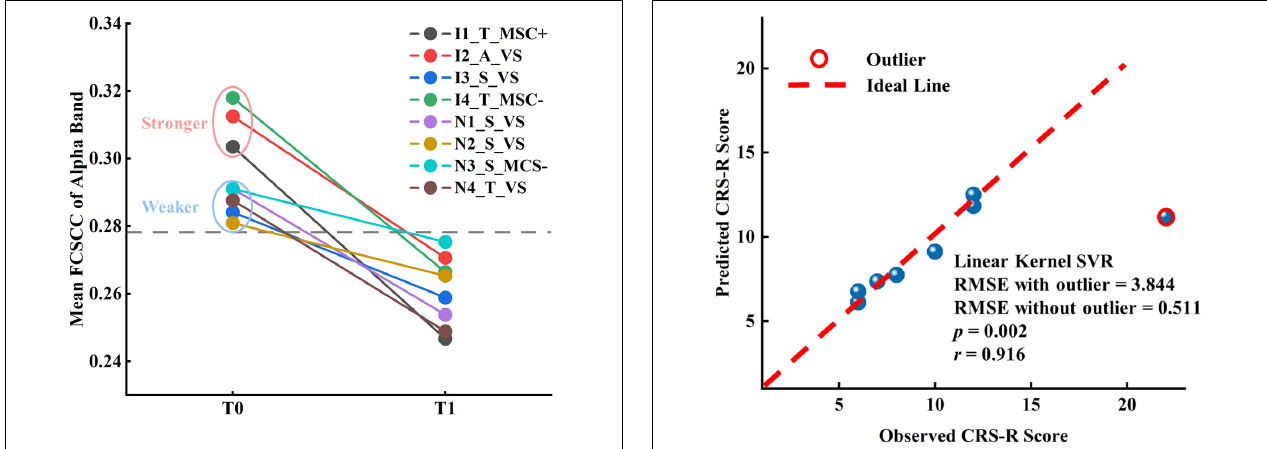
FIGURE 6 | Results of the linear kernel SVR model to predict the long-term prognostic outcome by EEG features at T0 and